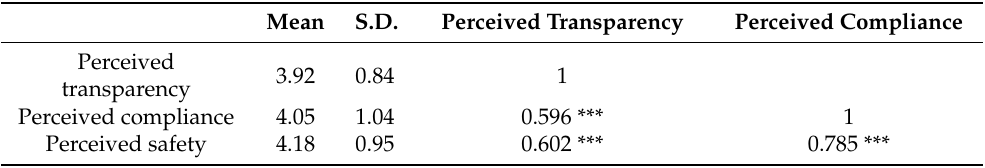
Table 7. Bivariate correlations between consumers’ perceived transparency, compliance, and safety (study 2; n =